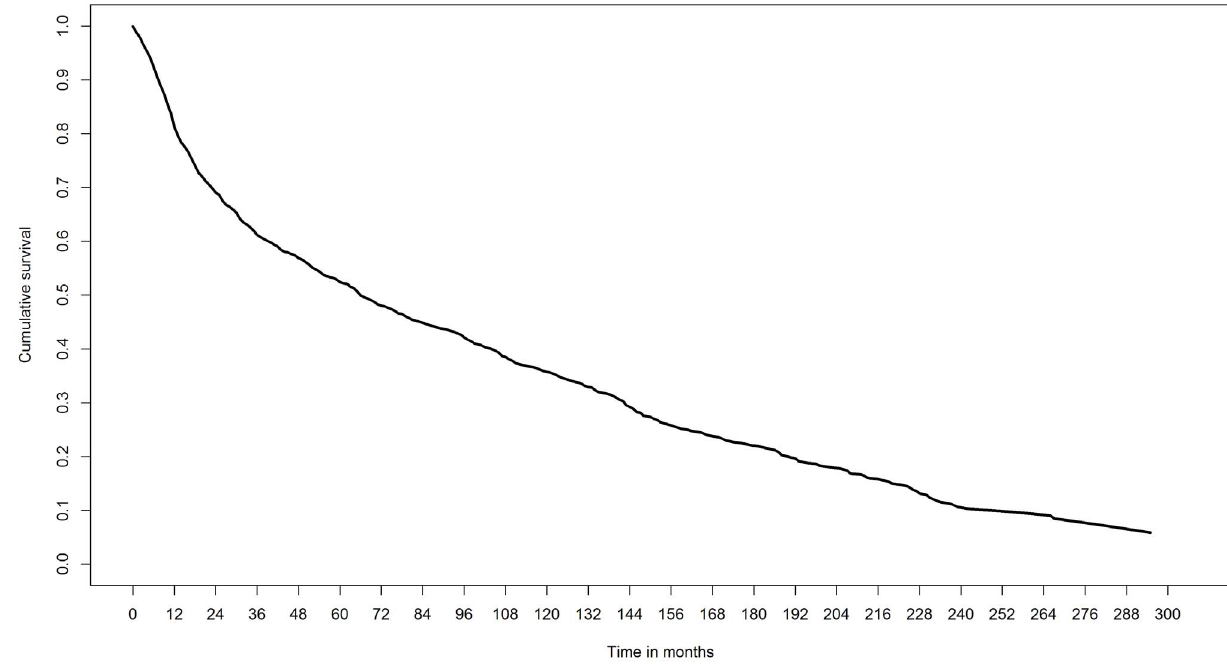
Figure 2. Censoring pattern 1282 patients with newly diagnosed HNSCC.